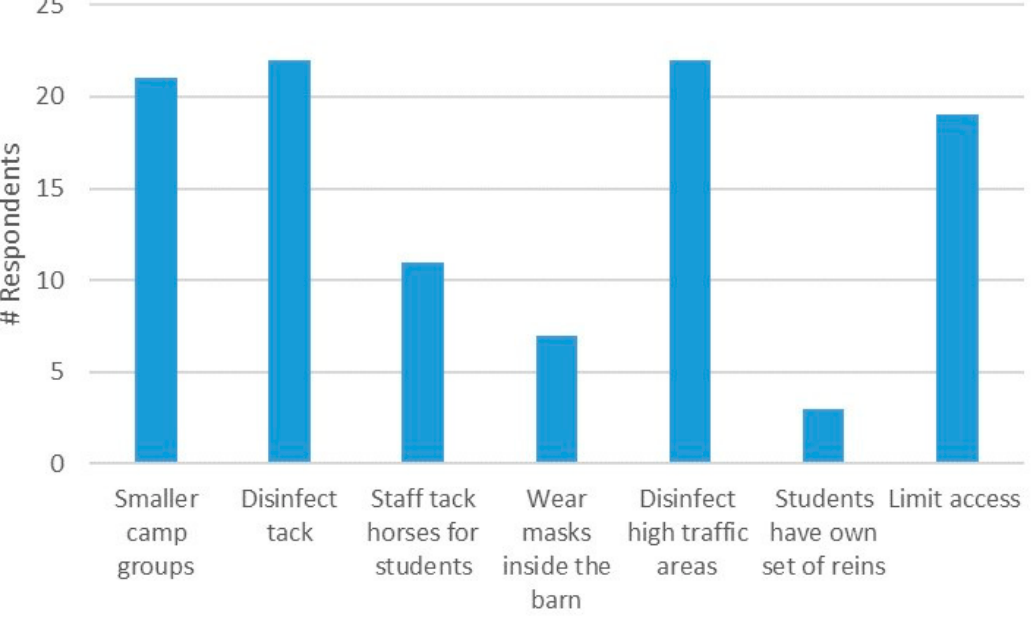
Figure 2. Precautions taken by survey respondents ( n = 28) to ensure safety during COVID-19 restrictions for summer equestrian camps in Ontario. Note that respondents could check all options that applied.